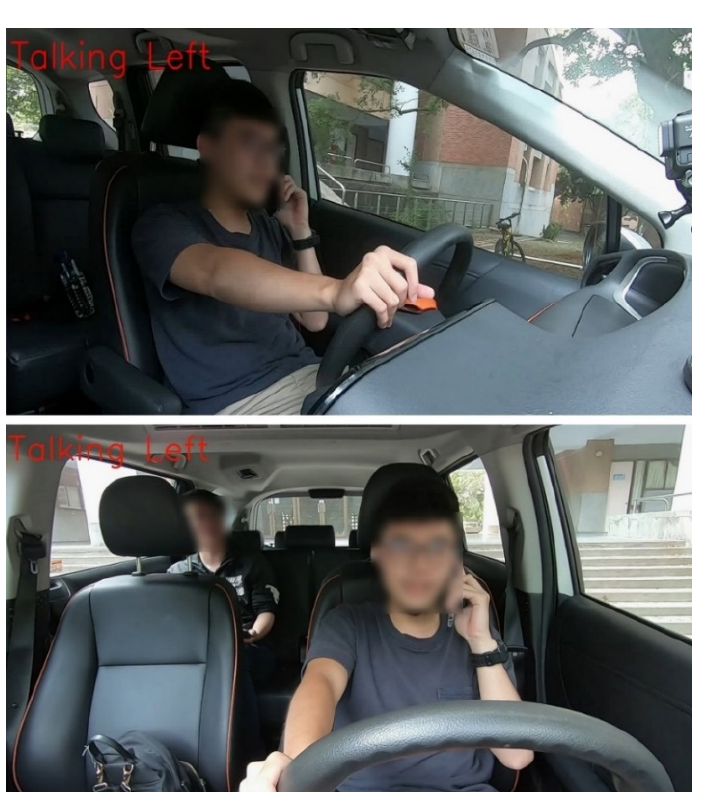
Figure 6 presented a resulting image for detecting distracted driving.